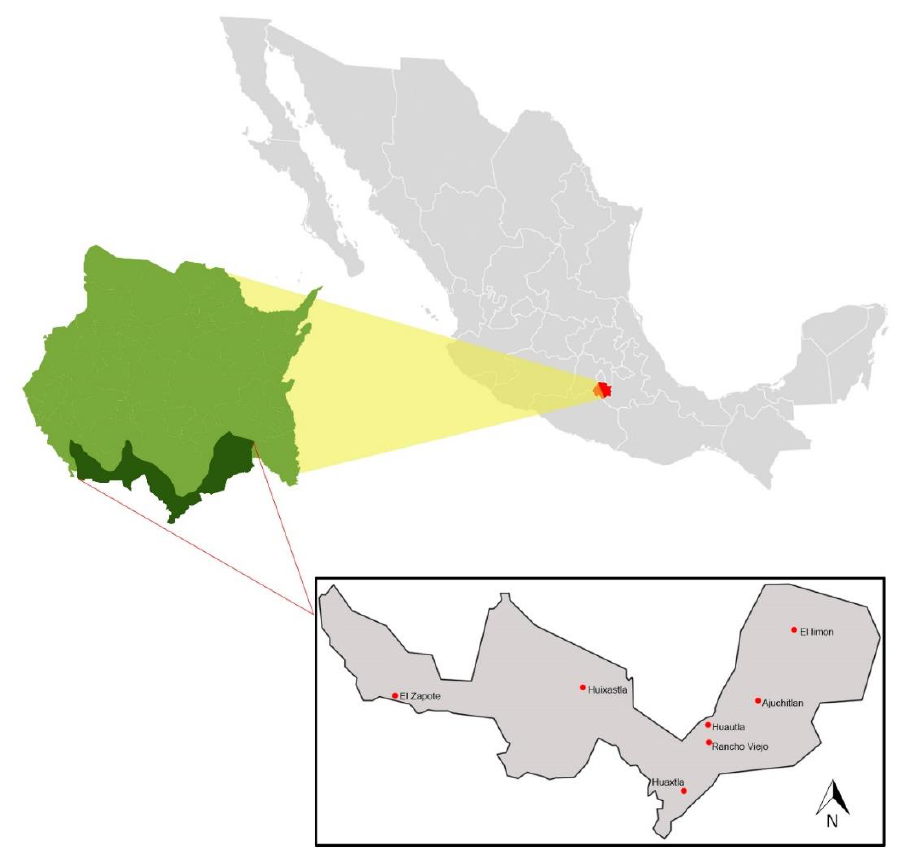
Figure A2. Location of REBIOSH in Mexico (Biosphere reserve of the Sierra de Huautla, Morelos State).